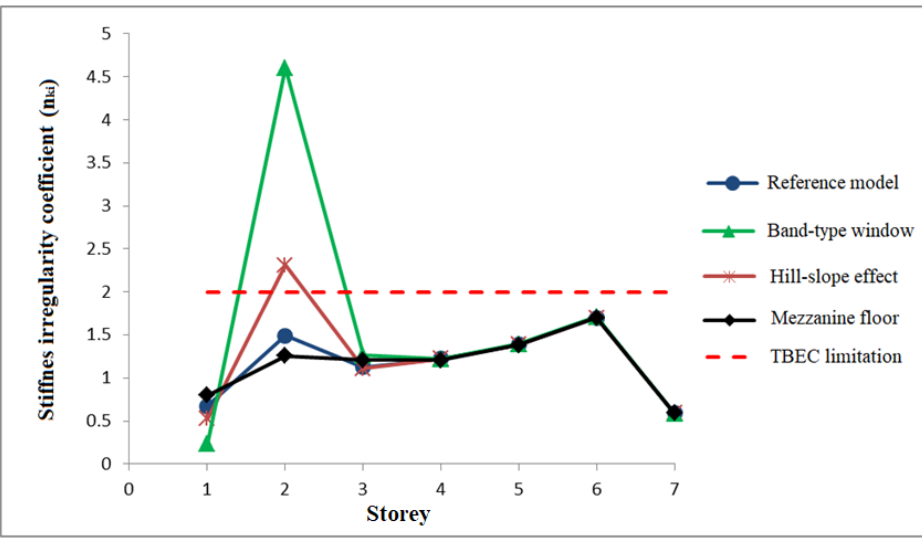
Figure 9. Stiffness irregularity coefficients (n ki ) of RC building models.